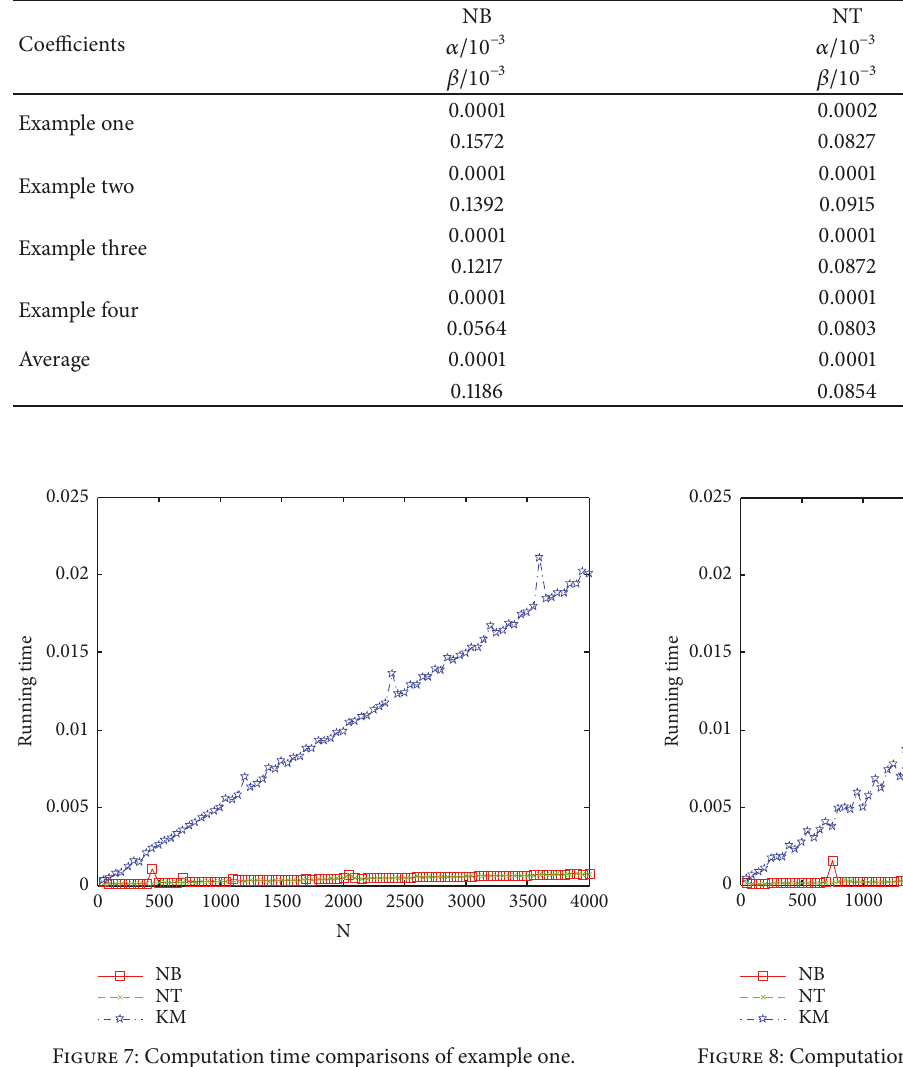
Table 3: Computations of the regression model coefficients by the least square for the NB, NT, and KM algorithms.